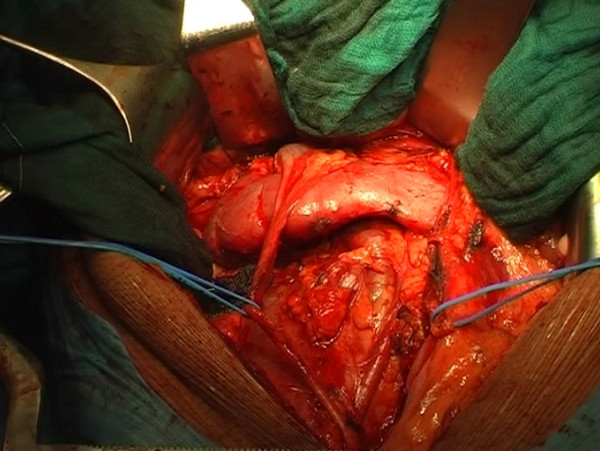
Horseshoe kidney and cava vein. The retroperitoneal mass, of diameter of about 6 cm, was infiltrating the psoas muscle and also the lateral wall of the cava vein that was interested in full-thickness to about 5 cm of extension, from its portion below the isthmus renal up to 3-4 cm from the ileo-caval confluence.